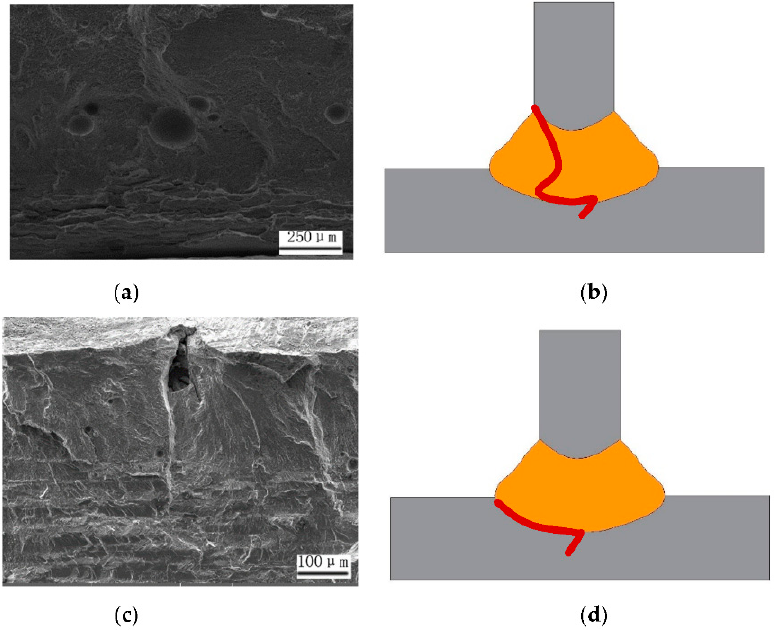
Figure 10. ( a ) The source of the crack is at the pore of the weld ( b ) Schematic diagram of fracture from the inside of the weld ( c ) The source of the crack is at the gap of the weld ( d ) Schematic diagram of fracture from the edge of the weld.